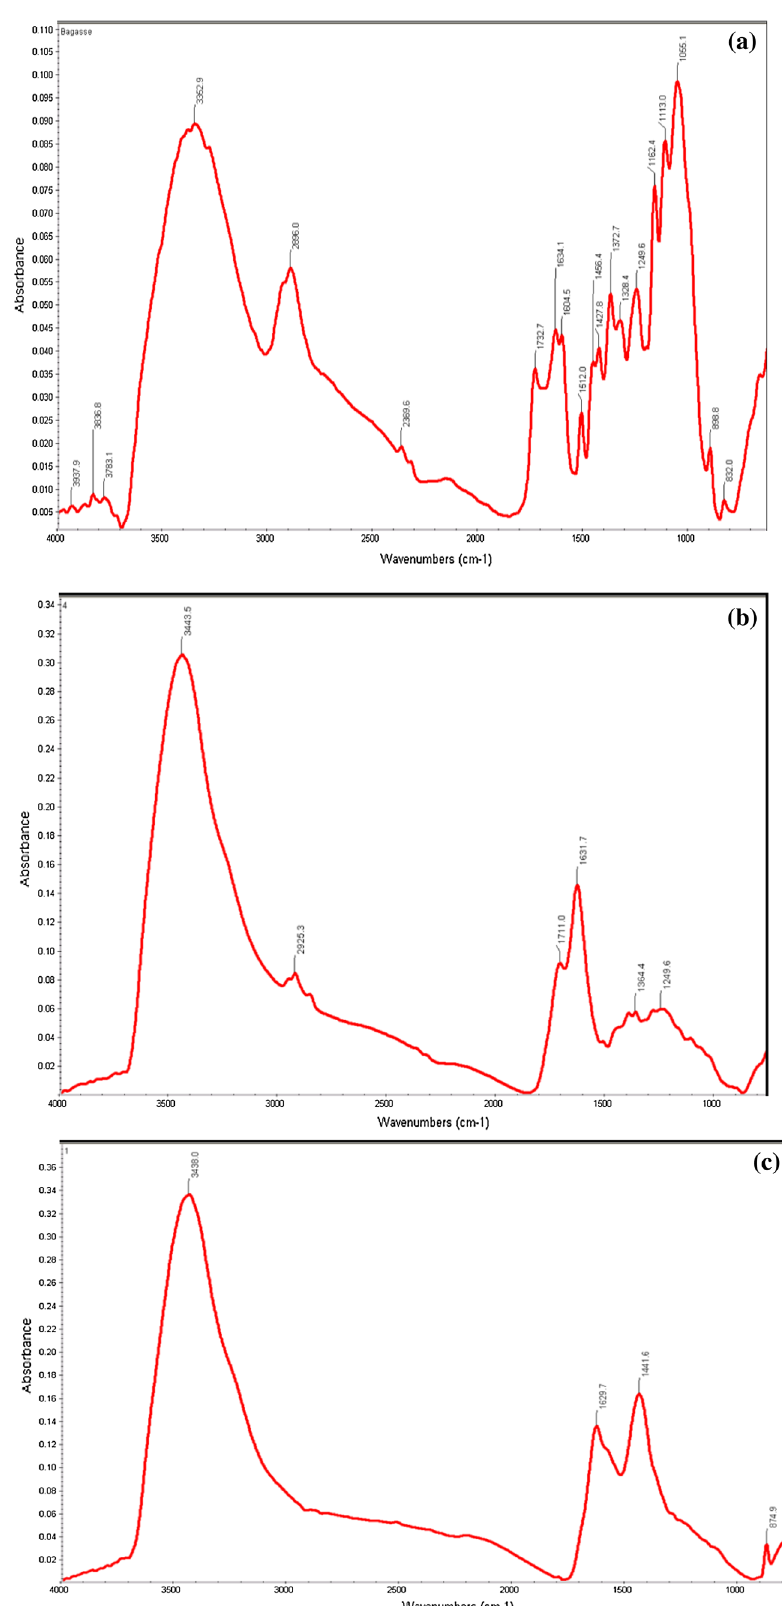
Fig. 3 FTIR spectra of : a bagasse, bagasse biochar before b and after c Pb 2+